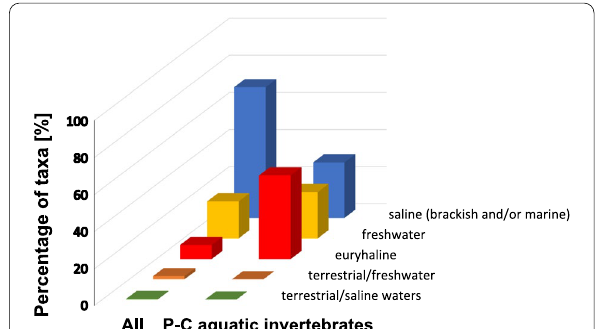
Fig. 1 Proportions of global nonindigenous aquatic invertebrate taxa (left) vs. Ponto‑Caspian aquatic invertebrate taxa (right) living in: (A) (top, blue) the saline adaptive zone, i.e., brackish and/or marine waters (0.5–35 ppt), (B) (yellow) the freshwater adaptive zone, i.e., + exclusively in fresh water (0–0.5 ppt), (C) (red) both the freshwater and saline adaptive zones (i.e., being euryhaline, 0–35 ppt), and (D) + (bottom) semi‑aquatic, e.g., inhabiting terrestrial and aquatic, either freshwater (D1, brown) or saline (D2, green) habitats, changing with life cycle